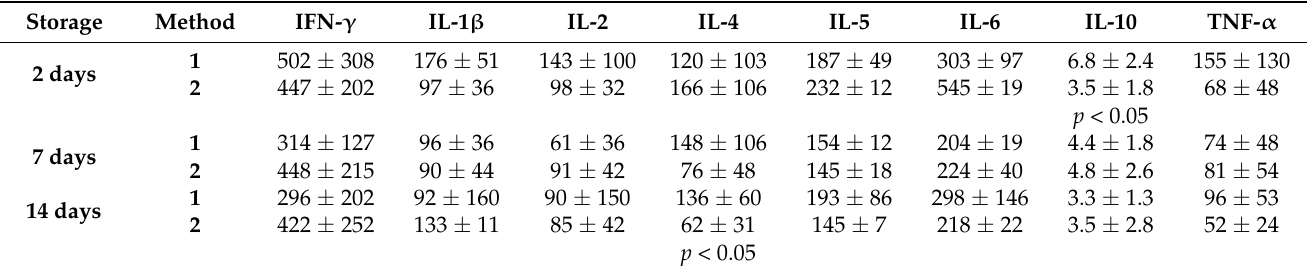
Table 2. Cytokine levels in the two methods at the different time points. p -value is reported when significant.